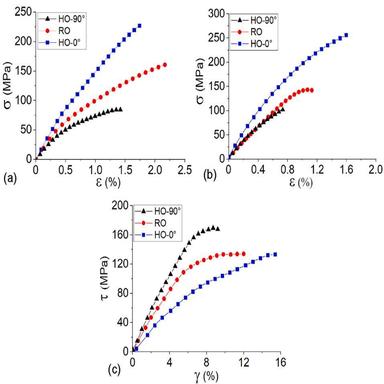
Stress-strain curves for (a) tension, (b) compression and (c) shear behavior of A-SMC composite with respect to the fiber orientation under quasi-static loading (i.e. 0.01 s − 1 ).